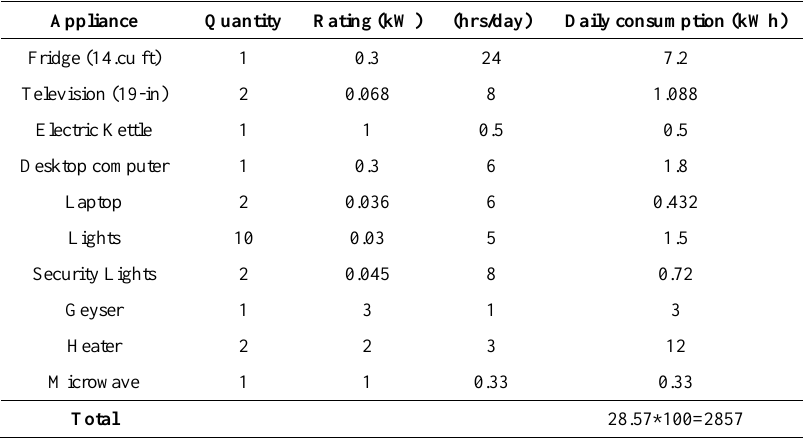
Table 6. Typical Load of Turkana District